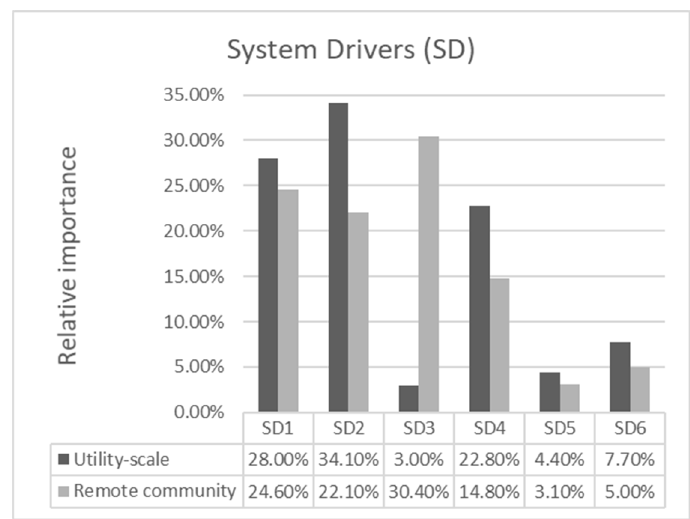
Figure 11. Relative importance of SD for the application market.